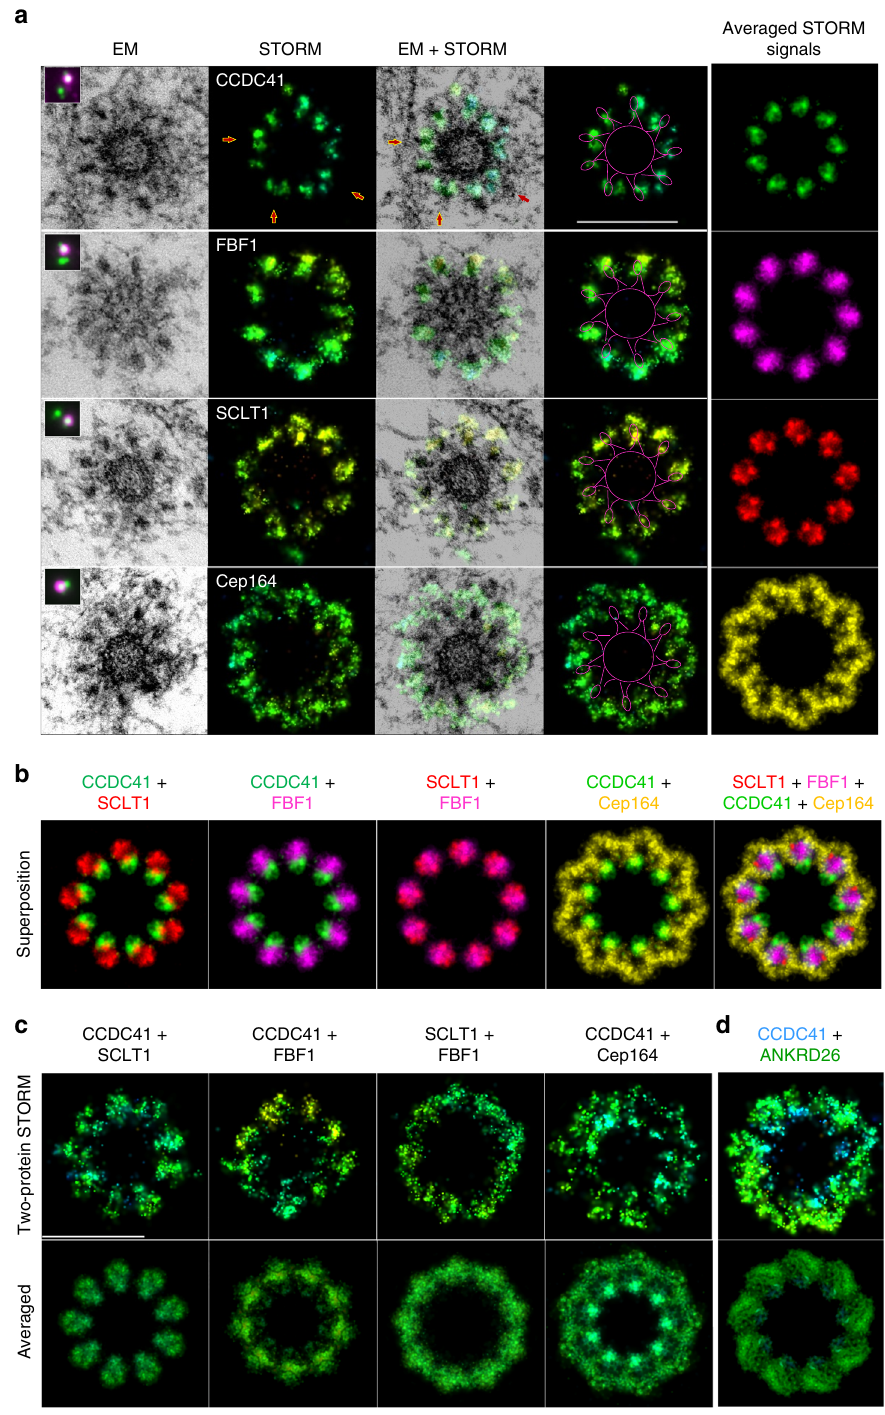
Fig. 3 Correlative STORM/EM analysis positions DAP signals with respect to EM densities. a RPE-1 C1-GFP cells were immunolabeled for the indicated DAPs and imaged fi rst in a wide- fi eld mode (magenta in inserts), followed by 3D STORM imaging, and correlative electron microscopy analysis. The panels show one 80 nm section containing DA EM densities, the STORM image of the same centriole, merged STORM and EM image, and the STORM image with a scheme delineating the centriole and the DA head densities. The averaged STORM signal is shown in the right column. Averaged signals were pseudo colored. b Averaged STORM images from ( a ) were rotated and then superimposed to generate a horizontal distributional map of the DAPs. c , d Two protein STORM analysis of indicated DAPs. Cells were simultaneously labeled for two DAPs in one channel and imaged by STORM. The averaged signals from all nine appendages are shown below. More examples of two-protein STORM are shown in Supplementary Figure 4, where the average outer and inner diameter of the toroid is noted. Scale bars: 400